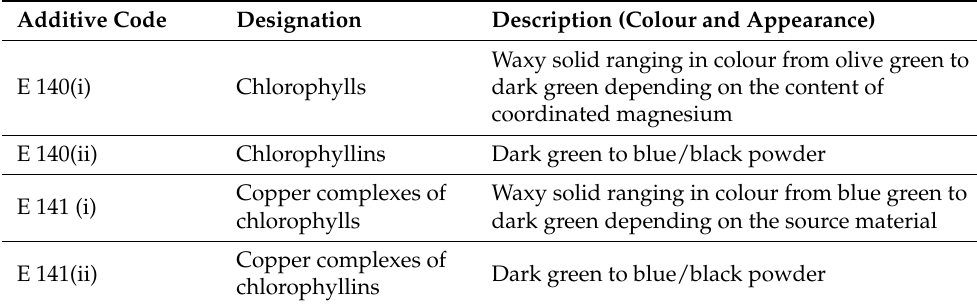
Table 1. Chlorophylls, chlorophyllins and their cupric complexes used as food colours. Additive Code Designation Description (Colour and Appearance) Waxy solid ranging in colour from olive green to E 140(i) Chlorophylls dark green depending on the content of coordinated magnesium Chlorophyllins Copper complexes of Copper complexes of Dark green to blue/black chlorophyllins